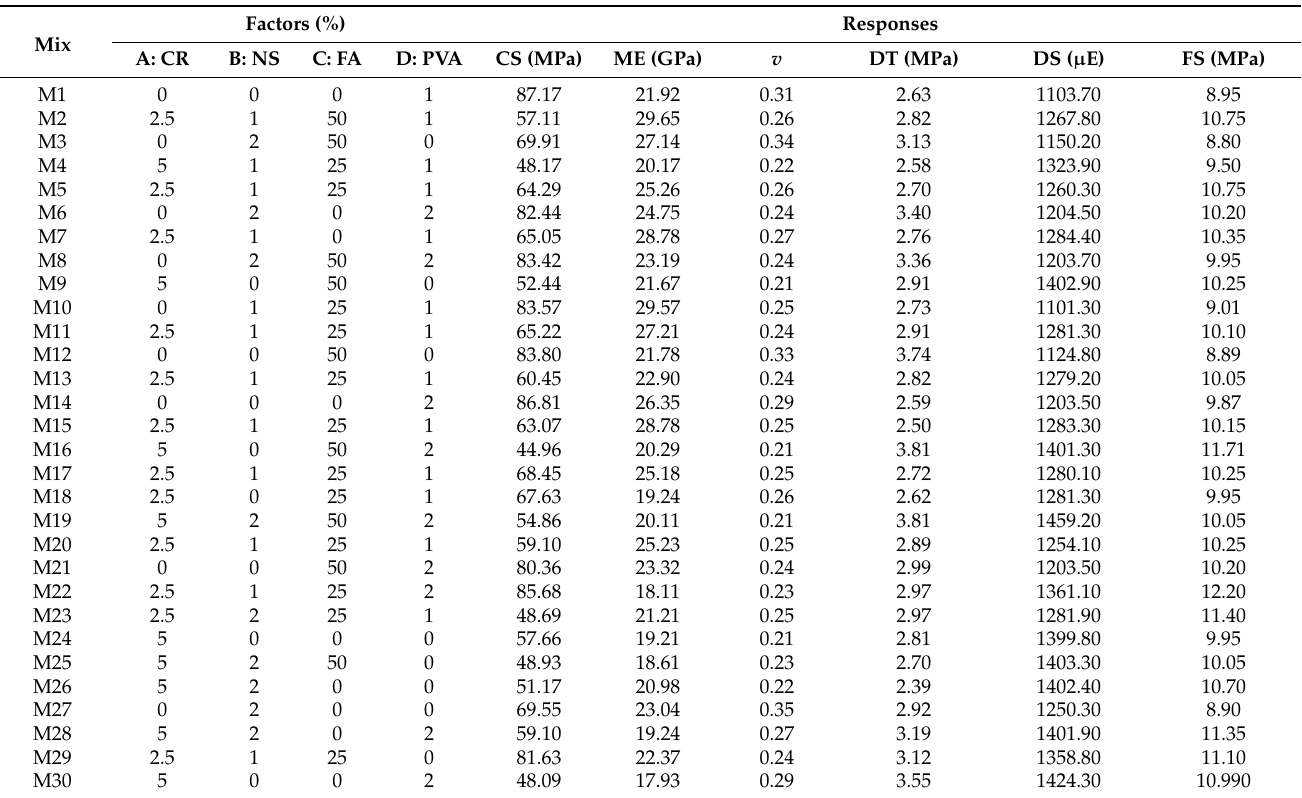
Table 5. Experimental design matrix and responses for rubberized ECC